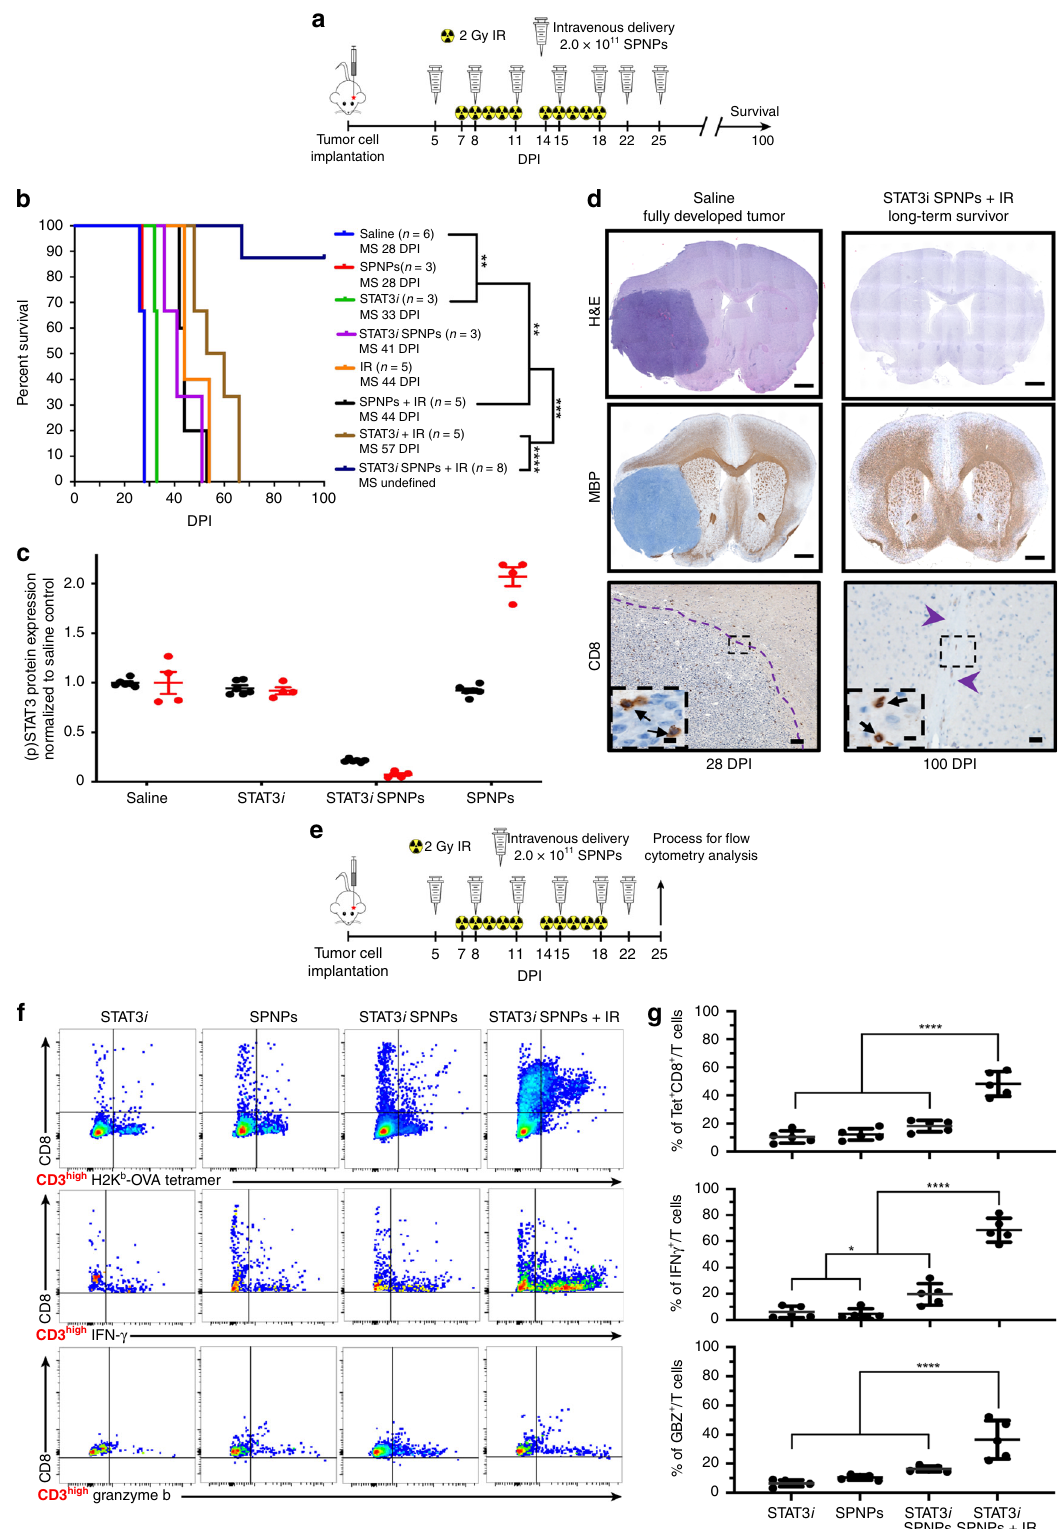
robust anti-GBM response elicited by the combined STAT3 i SPNP + IR therapy that is likely contributing to the observed therapeutic success. Recognizing that signi fi cant SPNPs accumulated in the liver (Fig. 2d), complete blood cell counts, serum biochemistry, and liver histopathological analysis were performed to